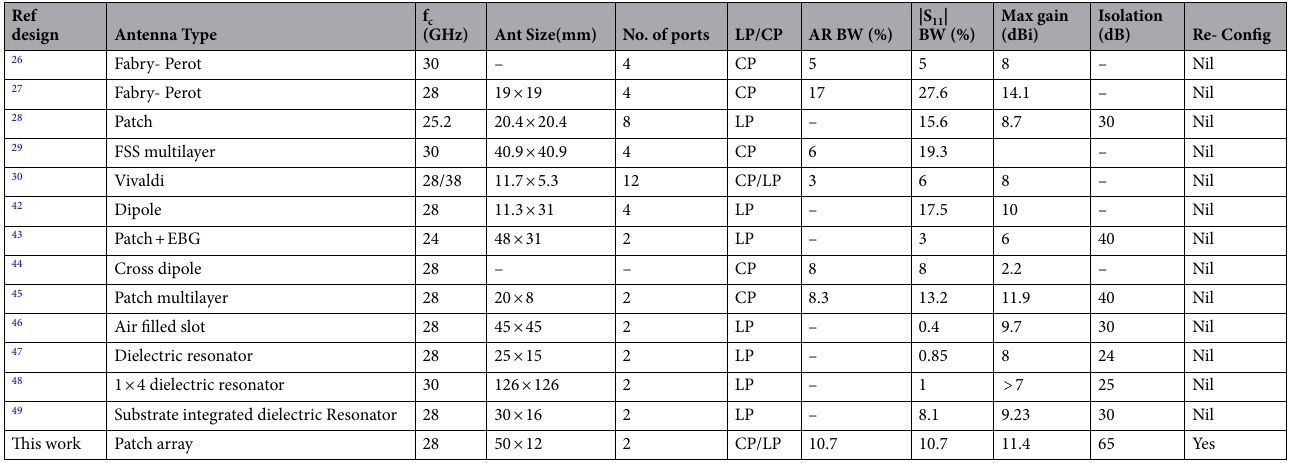
Table 4. State of the art